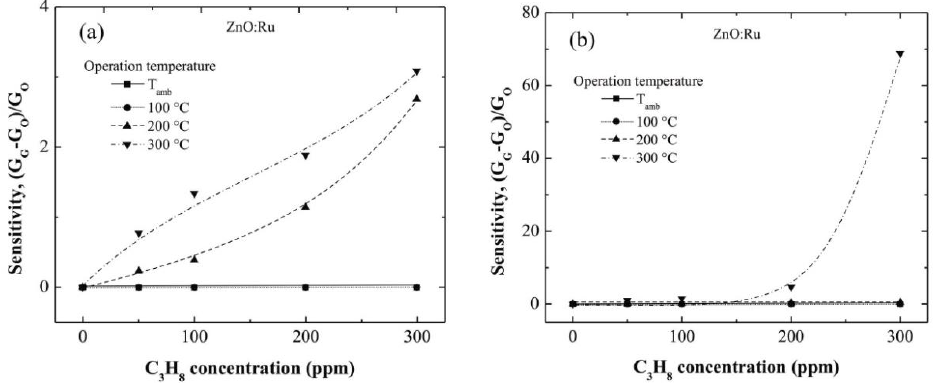
Figure 7. Sensitivity as a function of C Ru content, ( a ) one, ( b ) three, and ( c ) five immersions; measured at room temperature, 100, 200 and 300